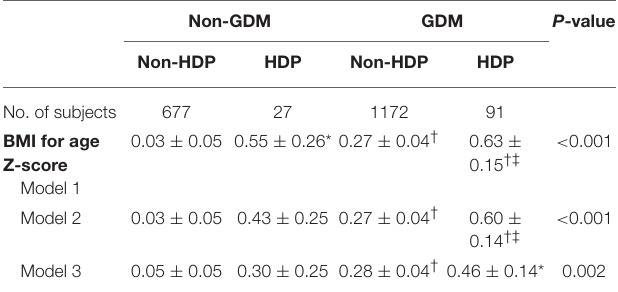
TABLE 2 | Comparison of BMI for age Z-score according to maternal gestational diabetes and hypertensive disorders of pregnancy. Non-GDM GDM P -value Non-HDP HDP Non-HDP